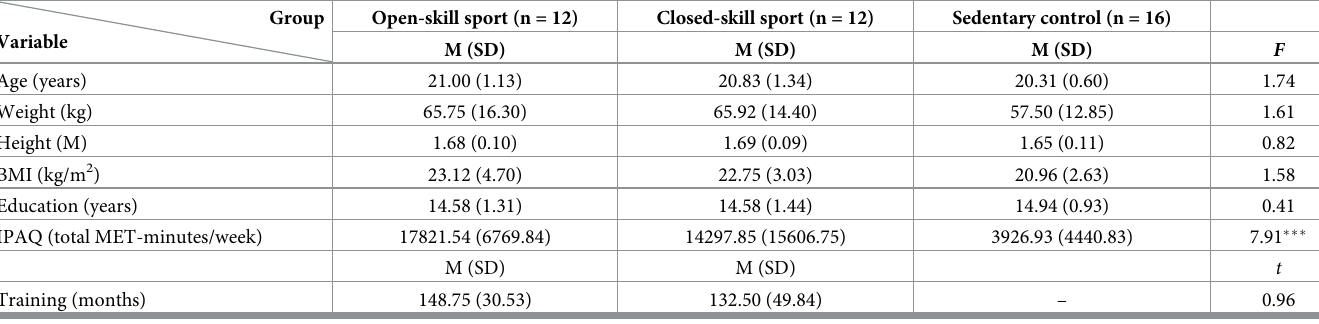
Table 1. Demographic statistics of the open-skill sport, closed-skill sport, and control